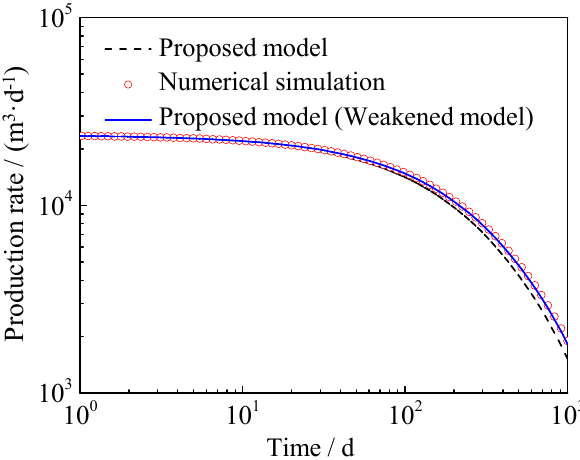
Figure 2. Comparison of results from numerical simulation and the proposed model. Table 1. Reservoir parameters for model validation and flow behavior